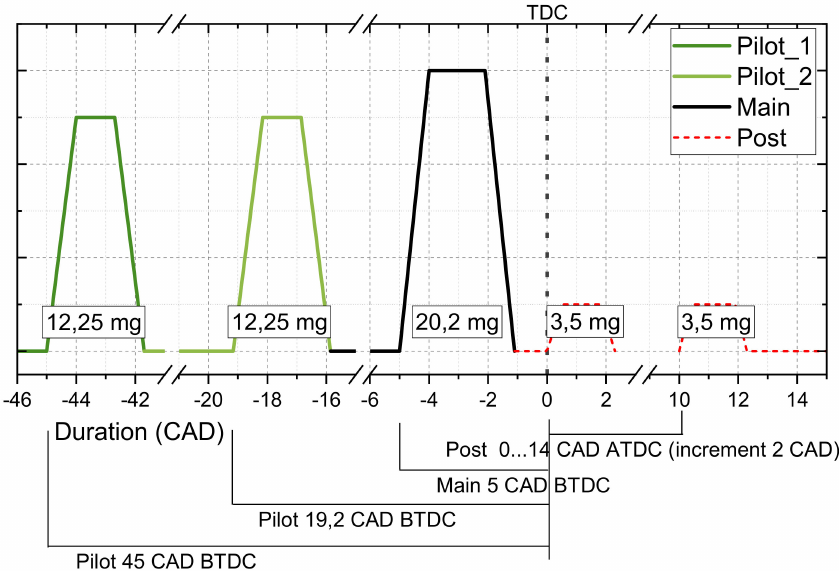
Figure 15. The four-stage injection strategy with post injection SOI variable.